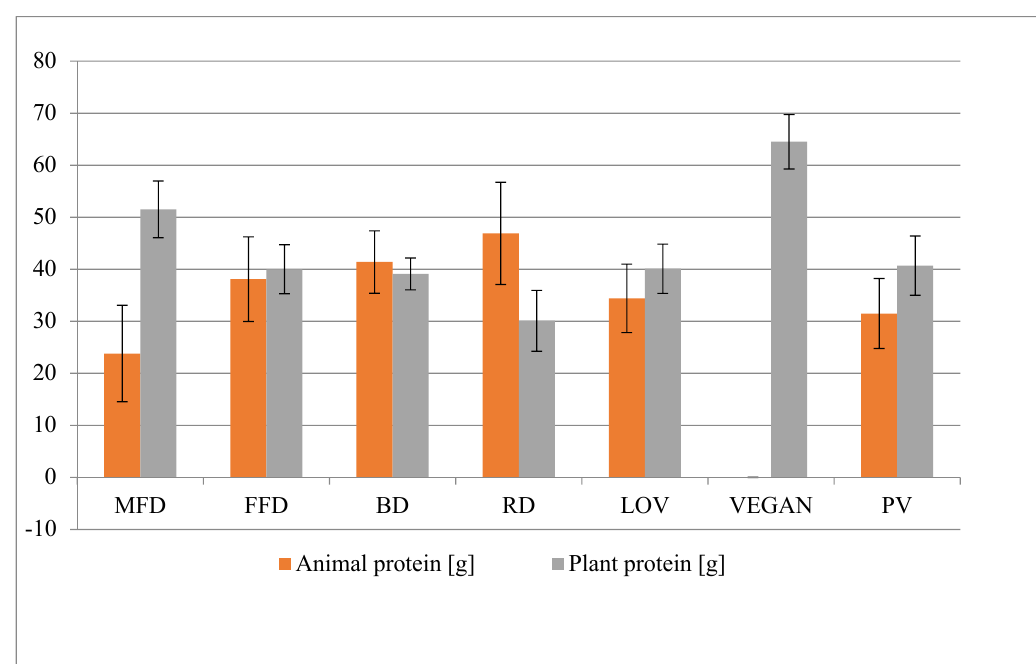
Figure 1. The average content of total plant and animal protein in the diets.